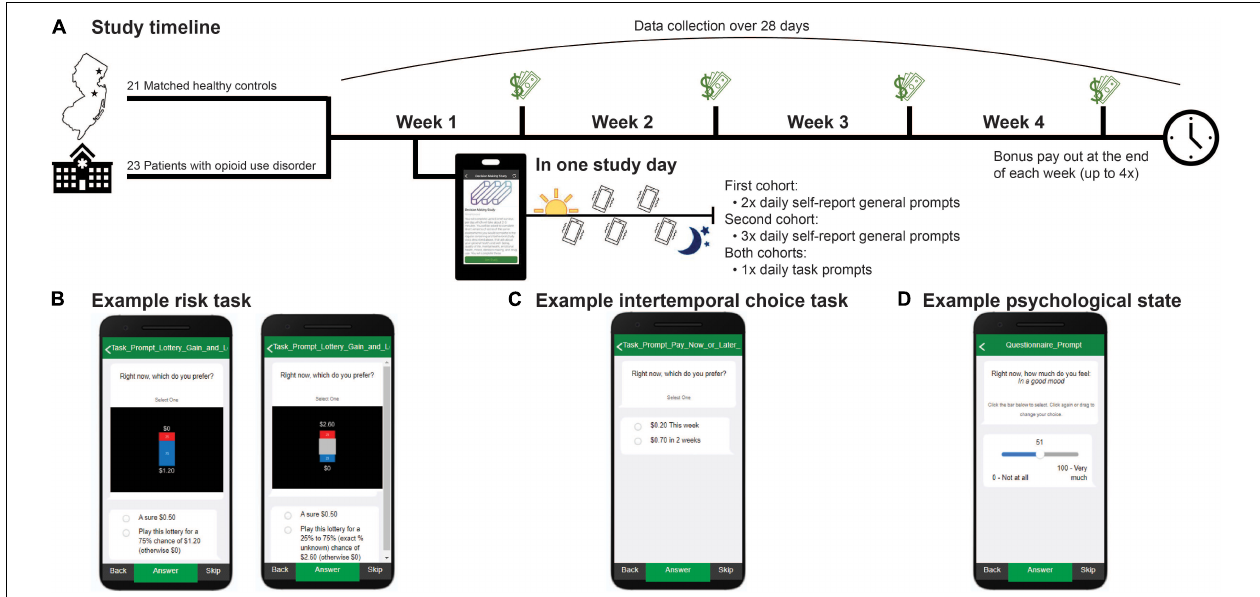
FIGURE 1 | Study timeline. (A) Forty-four subjects were enrolled in a 28-day ecological momentary assessment study. Subjects completed self-report surveys and decision-making tasks for real risky and delayed rewards from which a financial bonus was randomly selected and paid out at the end of each week. Select example screenshots of how behavior tasks and prompts were presented within the MetricWire app for: (B) known risk (left) and ambiguity (right) trials; (C) intertemporal choice task trials; and (D) psychological state questions.